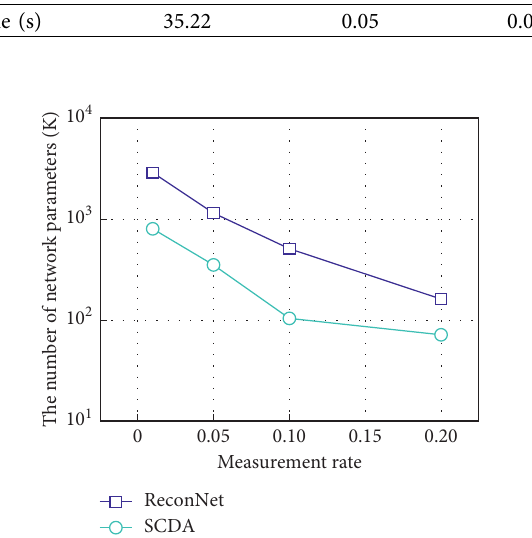
Figure 5: The number of network parameters for 10 images.